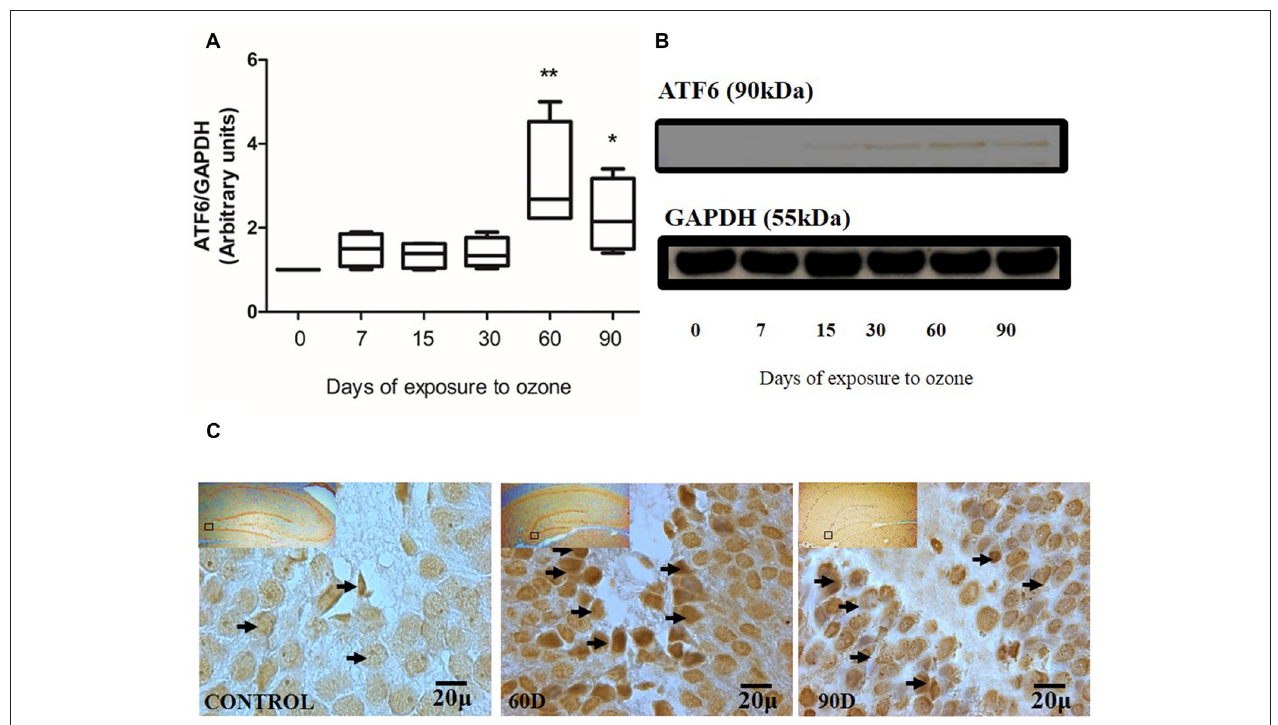
FIGURE 1 | Effect of chronic exposure to ozone on ATF6 expression in rat hippocampus. (A) Shows the densitometry analysis of the protein levels for ATF6 from rat hippocampus following exposure to ozone for 7, 15, 30, 60 and 90 days. Note the significant increase in the expression of ATF6 at 60 and 90 days of treatment. (B) The results show an increase in the protein expression following 60 ( ∗∗ p < 0.05) and 90 days of exposure to ozone ( ∗ p < 0.05) compared with the control groups. GAPDH staining was used as an internal control. (C) Effects of ozone treatments on ATF6 immunoreactivity in the dentate gyrus in rat hippocampus. Light photomicrographs show immunoreactivity of ATF6 in cells from hippocampus of rats exposed to ozone (arrows). The control group showed low immunoreactivity. We observed ATF6 translocation to the nucleus of the cells and an increase of immunoreactivity for ATF6 at 60 and 90 days of exposure to ozone. Arrows show ATF6 immunoreactivity 100 × . The square indicates the area that is shown as 100 × magnification.